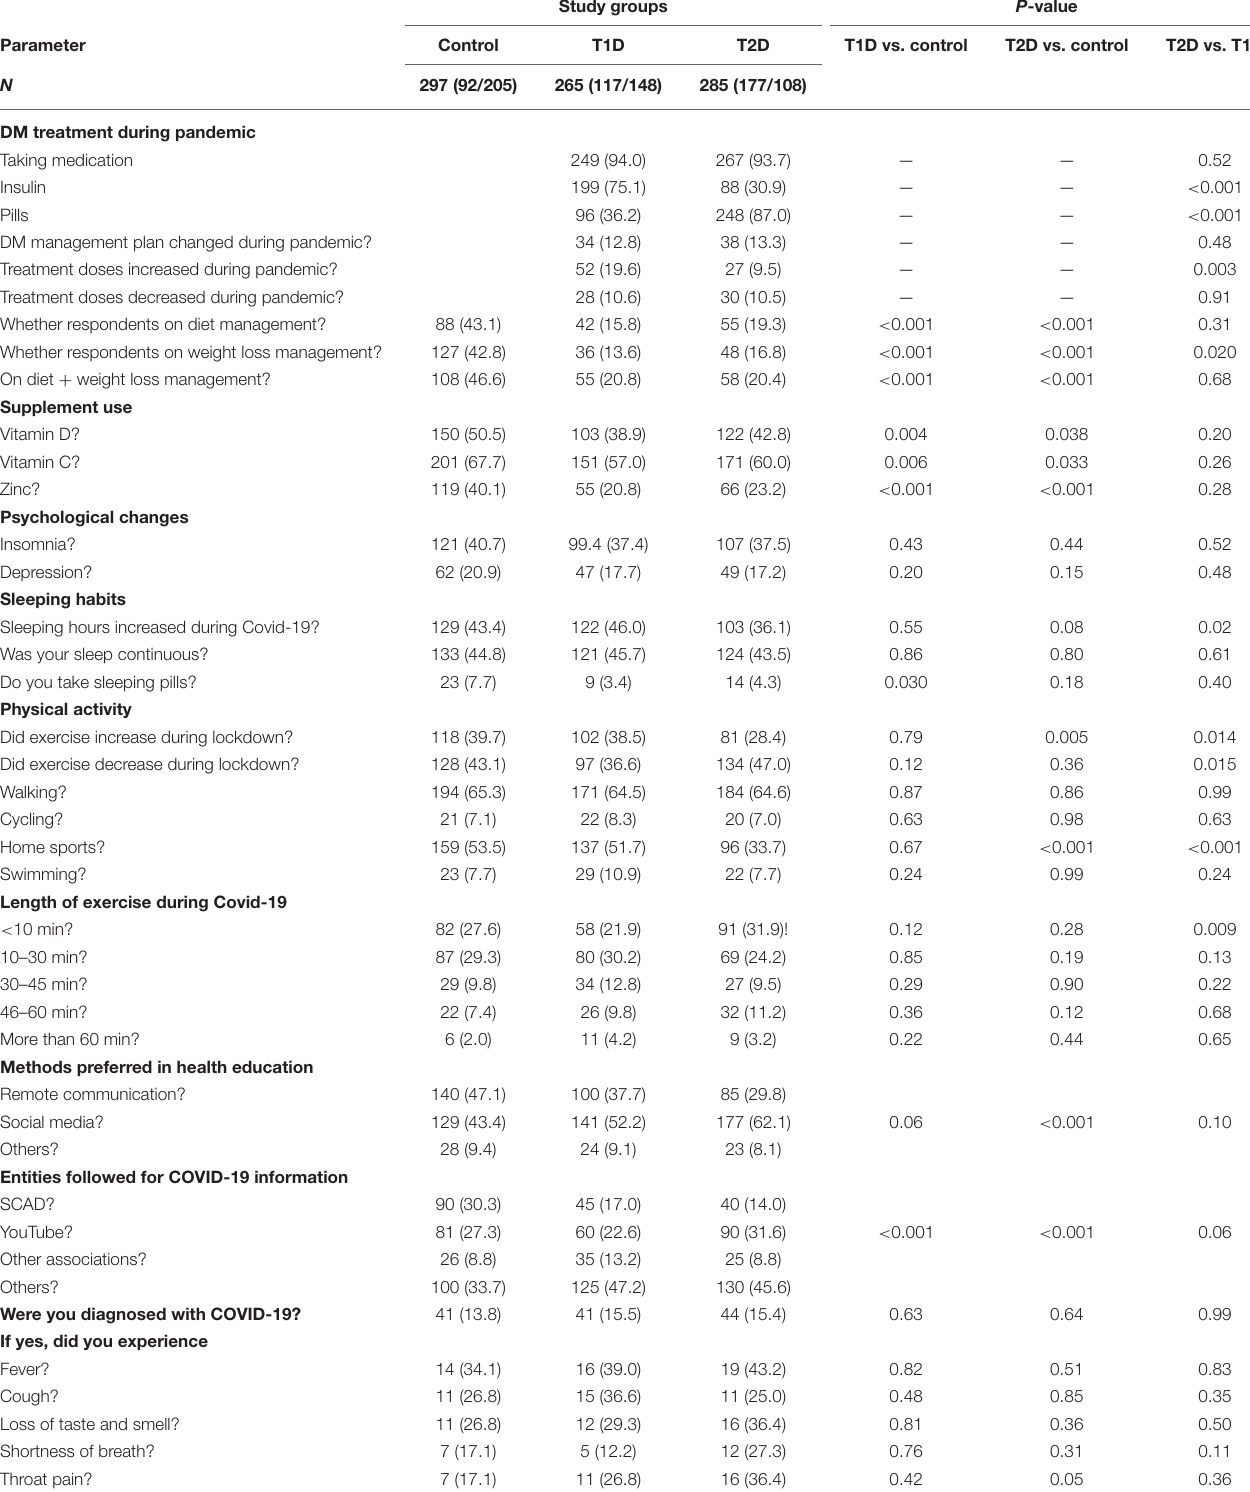
TABLE 2 | Differences in responses to yes/no questions in the study